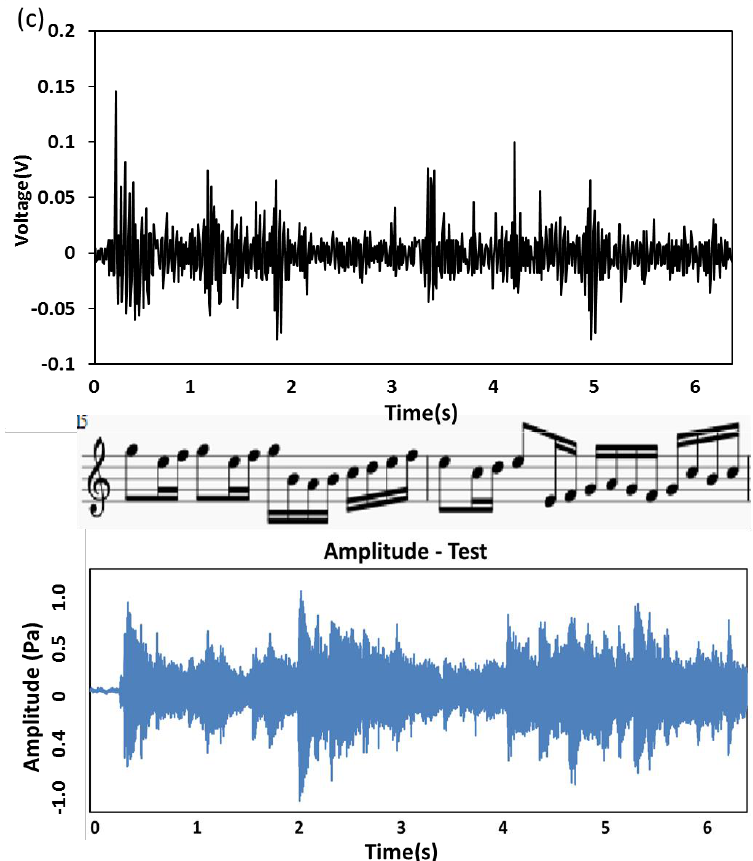
Figure 5. The ISSE showing the capability of voice recognition. The ISSE is placed on the top of the loudspeaker and recorded responses towards different scores of Canon-in-D ( a ) 1–4 measures of Canon-in-D ( b ) 9–12 measures of Canon-in-D ( c ) 29 and 30 measures of Canon-in-D. The black image in the upper row indicates the voltage output responses towards different parts of Canon-in-D as measured by ISSE in a self-powered manner and the staff notation in the middle row is corresponding to the three scores of Canon-in-D. The blue image in the bottom row indicates the amplitude profiles of the original audios as measured from a complete acoustic acquisition system and microphone. Relative voltage output as measured by ISSE corresponds to nearly synchronous response to the meter-measured profiles of the original audios.